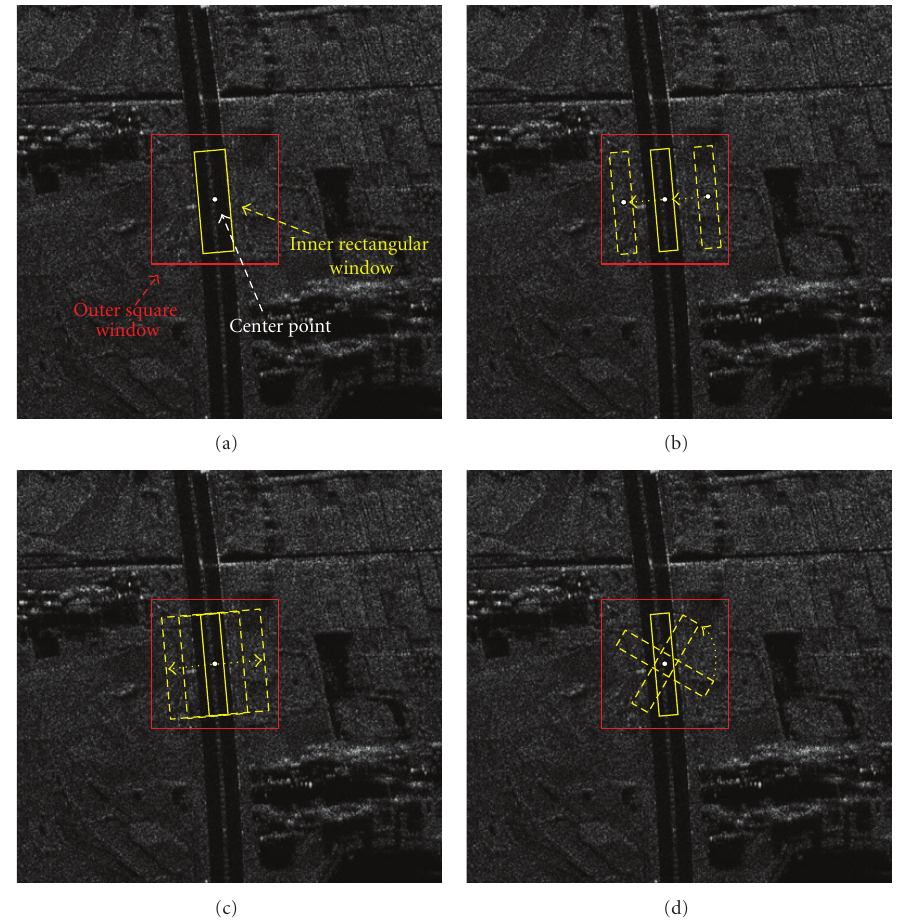
Figure 4: Double window. (a) Definition. (b) Inner window shifting. (c) Inner window expanding. (d) Inner window